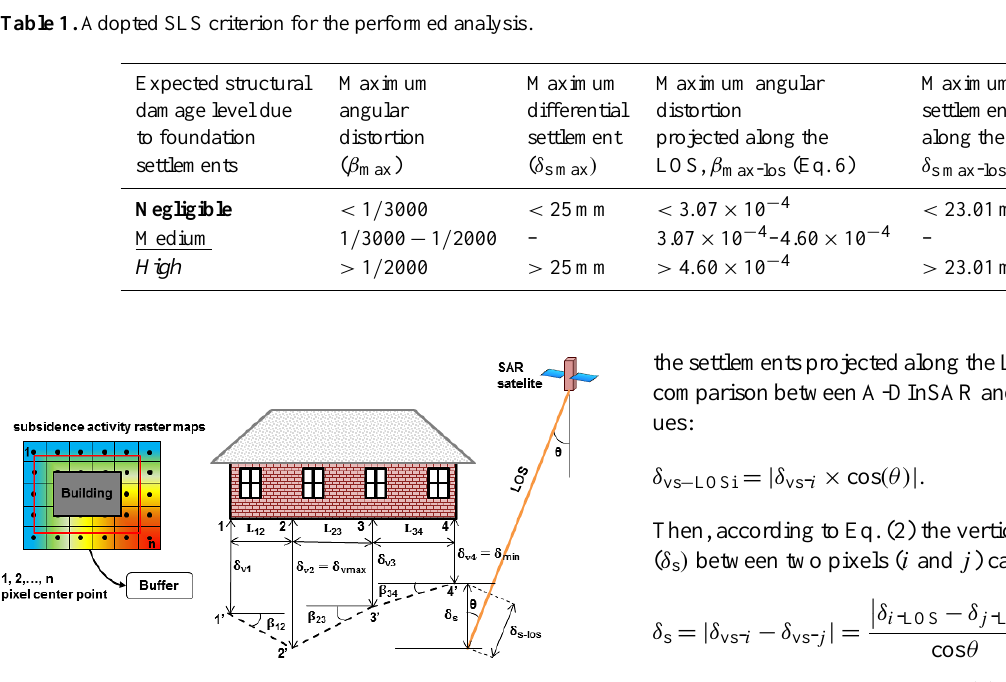
Figure 3. Schematic explanation of the serviceability limit state pa- rameters adopted in the